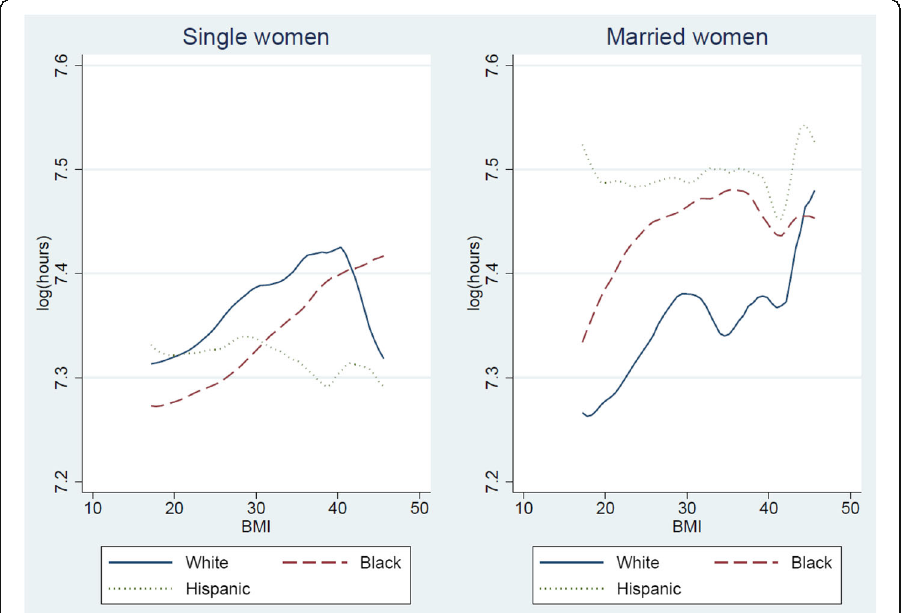
Fig. 5 BMI and log hours of work for women: semiparametric estimates. Note: Control variables include work experience (quadratic), educational categories, dummies for whether the woman believes in traditional gender roles, whether the respondent has any children, if the youngest child is below six, yearly age dummies, region of residence dummies, and year dummies. For the married sample, additional controls include spouse ’ s age, educational categories, and annual